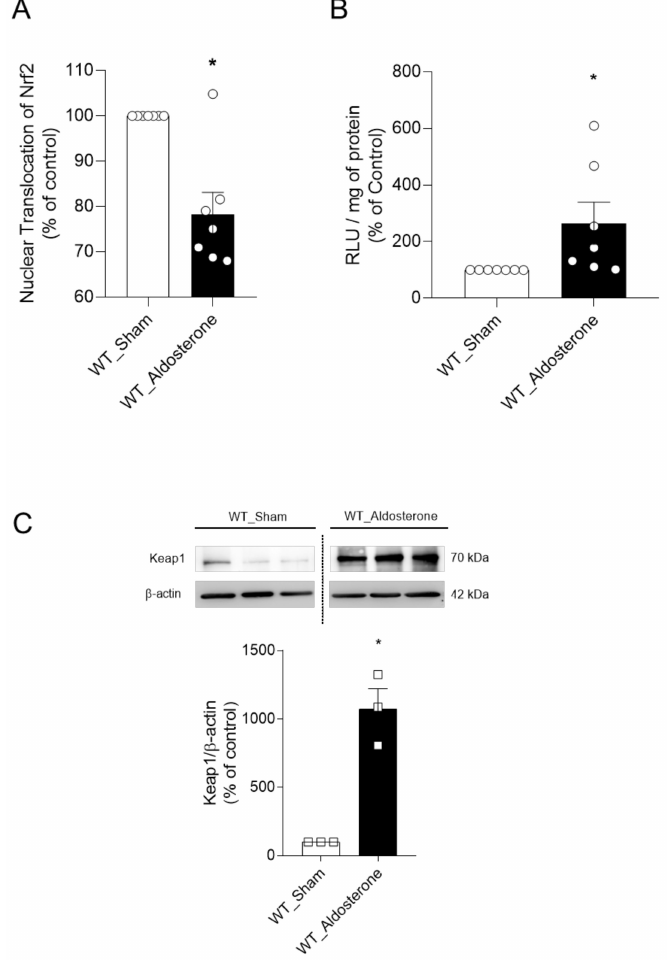
Figure 6. Aldosterone infusion in mice reduces vascular Nrf2 nuclear accumulation, increases Keap1 expression, and promotes oxidative stress. Nuclear accumulation of Nrf2 ( A ) and superoxide anion ( B ) levels in aortas from vehicle- and Aldo-infused mice. Protein expression of Keap1 ( C ) in aortas from vehicle- and Aldo-infused mice. The vertical dotted line between the groups indicates that the image obtained from the same membrane was cropped. Data represent the mean ± SEM. Student’s t -test: *, p < 0.05 vs. WT_Sham. n = 5–7 for each experimental